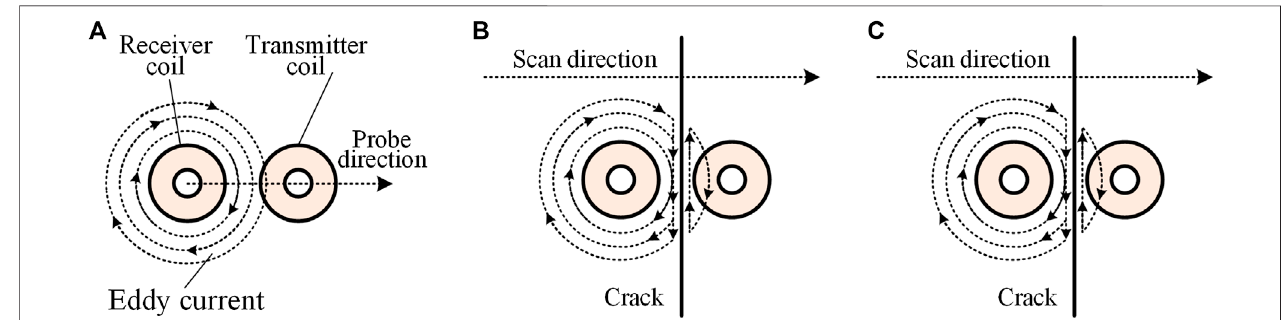
FIGURE7| In fl uenceofT-Rprobedirection: (A) probedirectionde fi nition; (B) probedirectionisalongthescandirection; (C) probedirectionisperpendiculartothe scan direction.